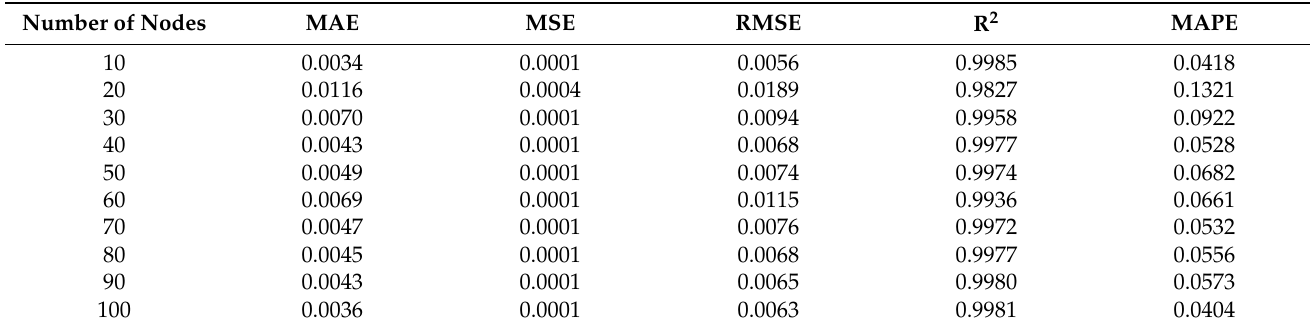
Table 3. Performance metrics of CNN for different number of nodes on the train set.